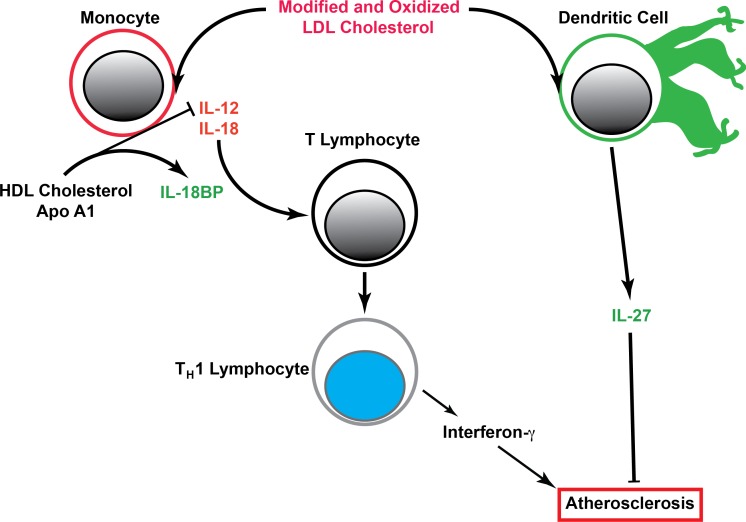
Cellular mechanism of cholesterol induced TH1 lymphocyte differentiation and atherosclerosis.Dendritic cells and monocytes recognize modified and oxidized LDL cholesterol. In monocytes, this results in release of IL-12 and IL-18 that act on T lymphocytes to promote polarization to TH1 lymphocytes, and promote release of interferon-γ. HDL cholesterol and recombinant HDL particles containing apolipoprotein A1 (ApoA1) suppress transcription of IL-12. IL-18 binding protein (IL-18BP) absorbs IL-18, modulating TH1 activation and interferon-γ release. Interferon-γ augments atherosclerosis. Oxidized LDL promotes release of IL-27, which attenuates atherosclerosis.